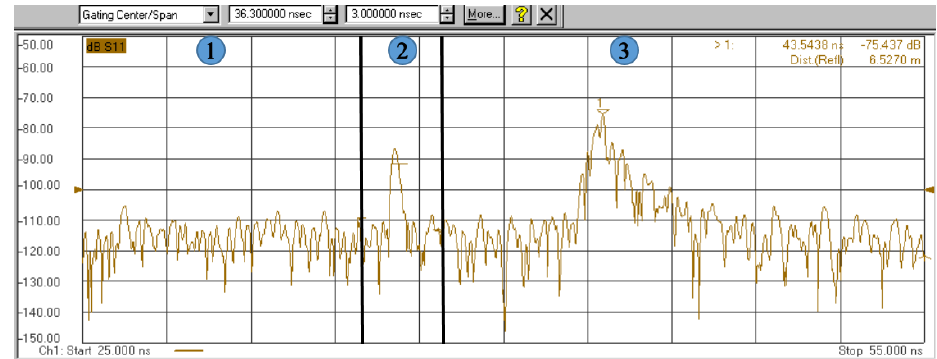
Fig. 6. Reflected signal time domain diagram with with 50 mm diameter metal ball, made with the measuring